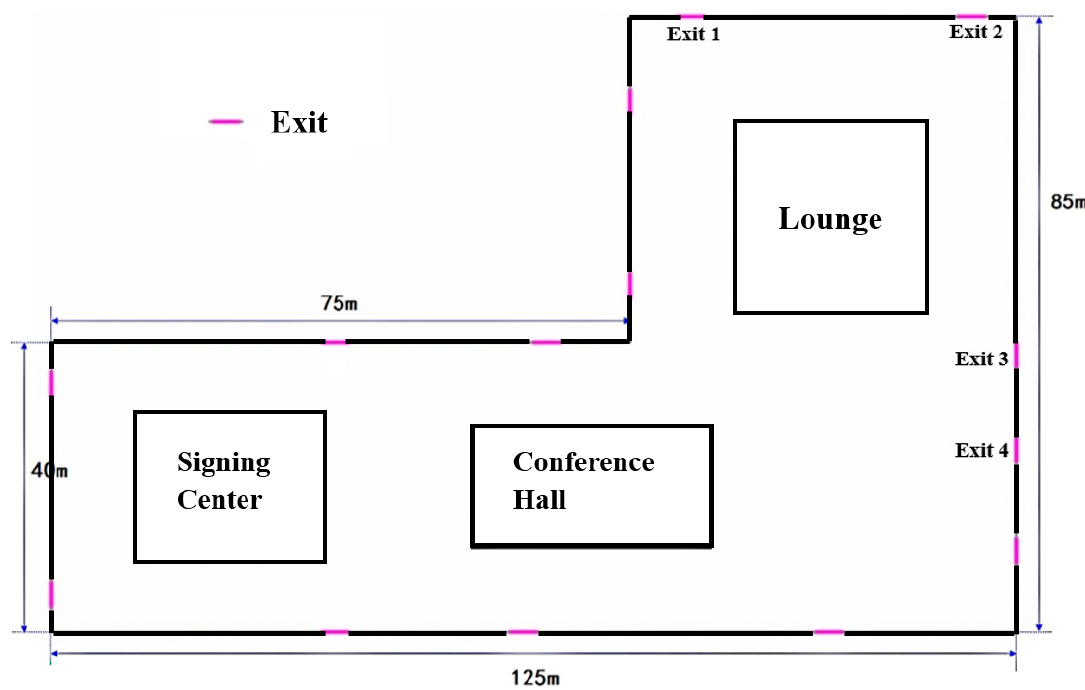
Figure 22. Exhibition center plan.